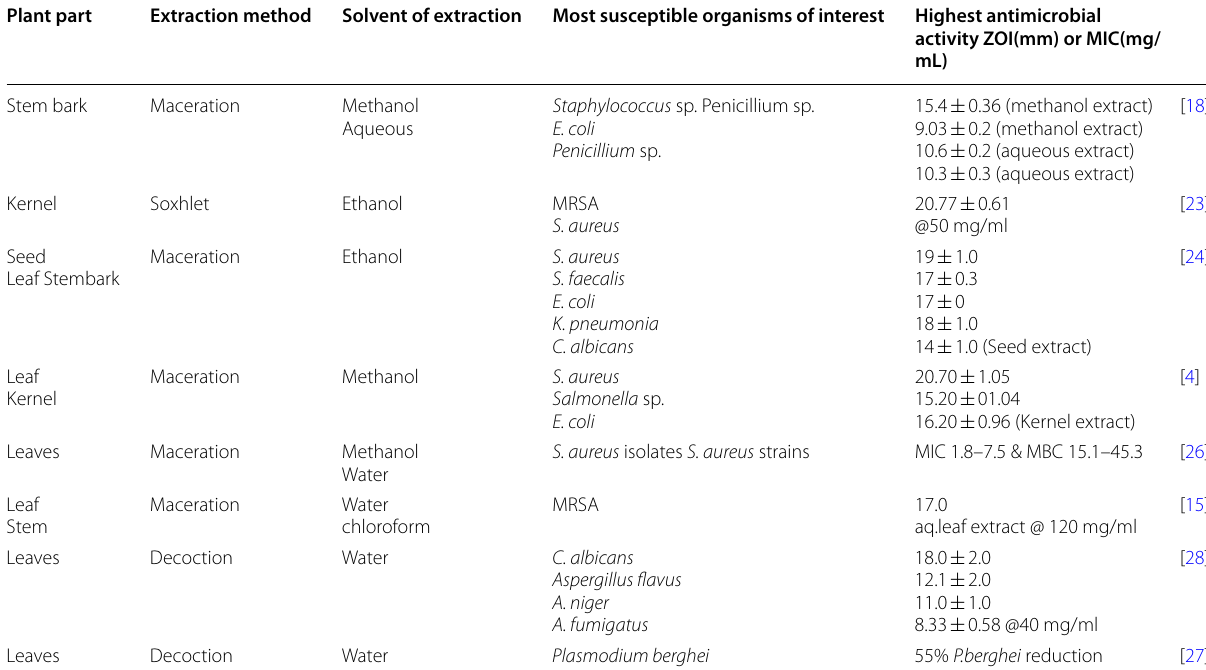
Table 1 Summary of mango plant part extracts and their antimicrobial effects on selected microbes Plant part